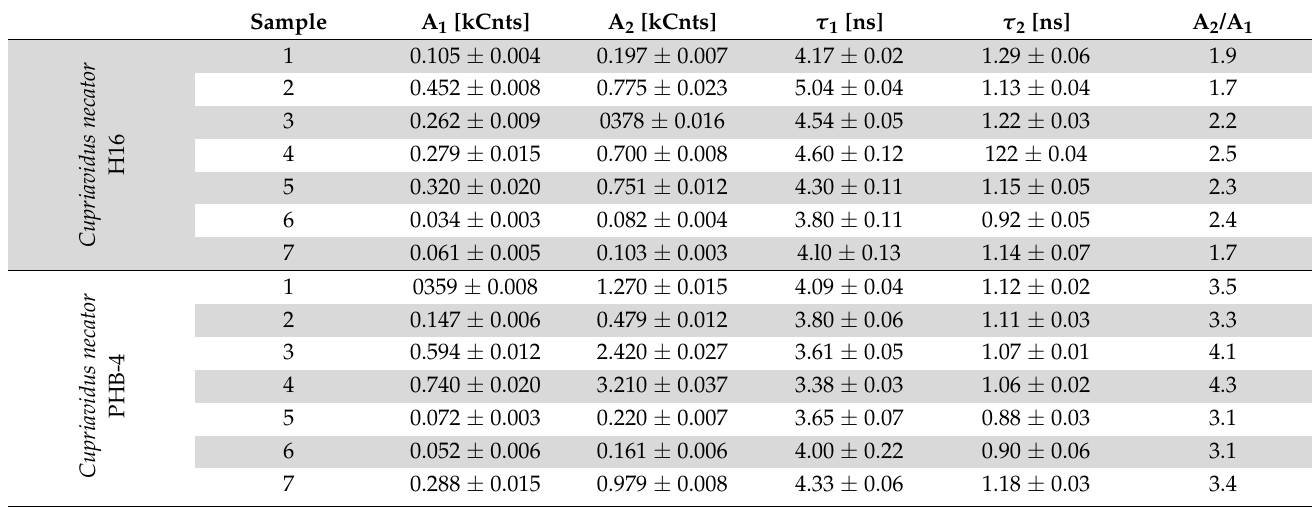
Table 1. Fluorescence intensity, A [kCnts]; and average fluorescence lifetimes, τ 1 and τ 2 , for cho- sen samples.